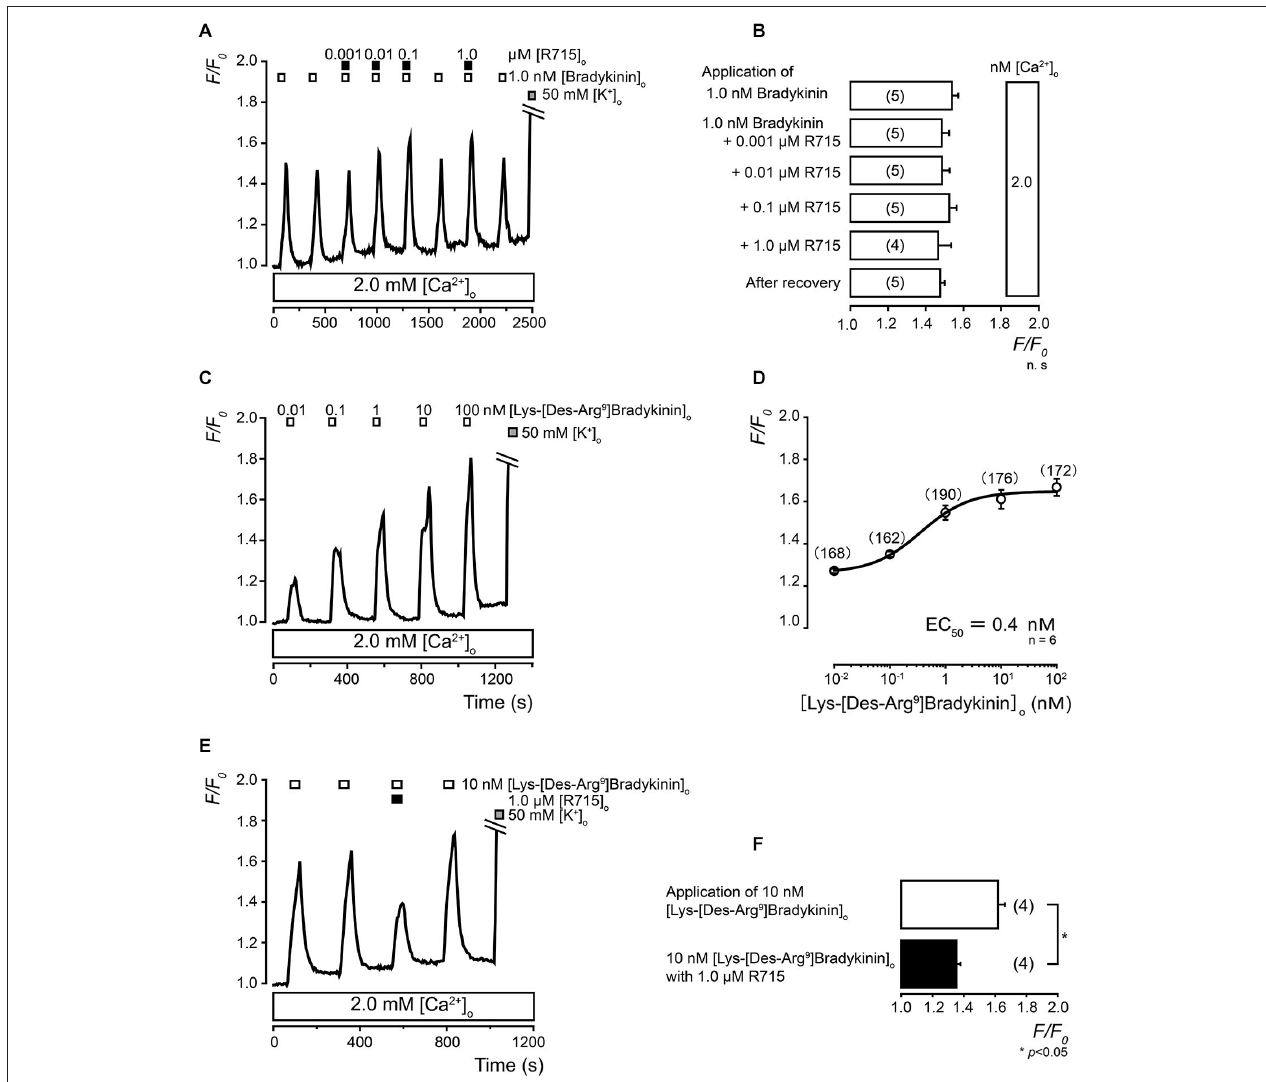
illustrate the F/F 0 values as a function of the applied concentrations of Lys-[Des-Arg 9 ]BK. Each data point represents the mean ± S.E. of six independent experiments (the numbers in parentheses represent the number of tested cells). The curve on the semilogarithmic scale was fitted according to Equation 1 , which is described in the text. The equilibrium-binding constant for Lys-[Des-Arg 9 ]BK was 0.4 nM. (E) Examples of Lys-[Des-Arg 9 ]BK-induced (10 nM; upper white boxes) [Ca 2 + ] i increases that were significantly inhibited by 1.0 µ M of R715 (upper black box) in the presence of external Ca 2 + (2.0 mM; lower white box). (A,C,E) The application of 50 mM of the KCl solution is shown in the gray boxes. (F) Summary bar graph of the [Ca 2 + ] i increases following 10 nM of Lys-[Des-Arg 9 ]BK with (lower black column) or without (upper white column) 1.0 µ M of R715. Each column denotes the mean ± S.E. of the indicated number (in parentheses) of independent experiments. The statistical significance between the columns (shown by solid lines) is indicated by asterisks: * p <